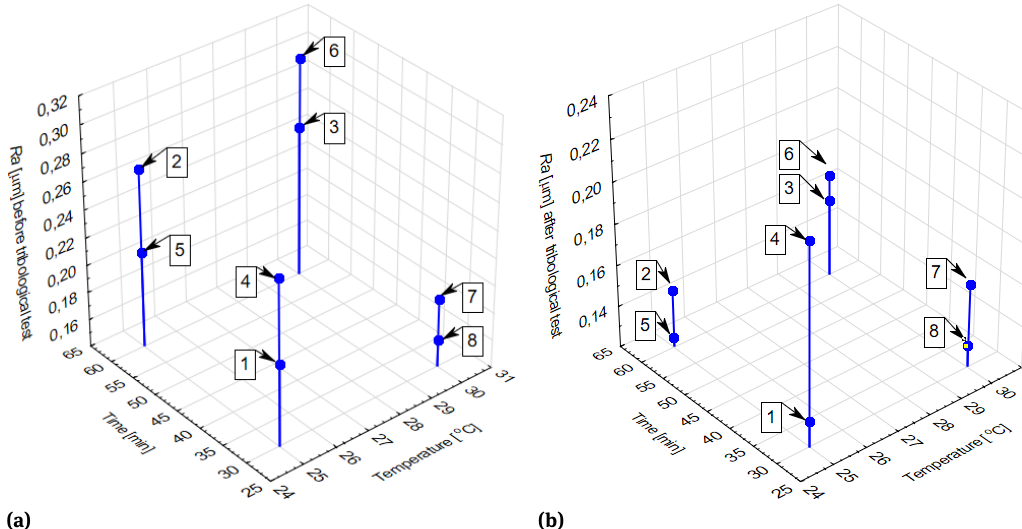
Figure 4: The scatter charts of Ra surface roughness over time and temperature of anodizing process a) before b) after tribological test